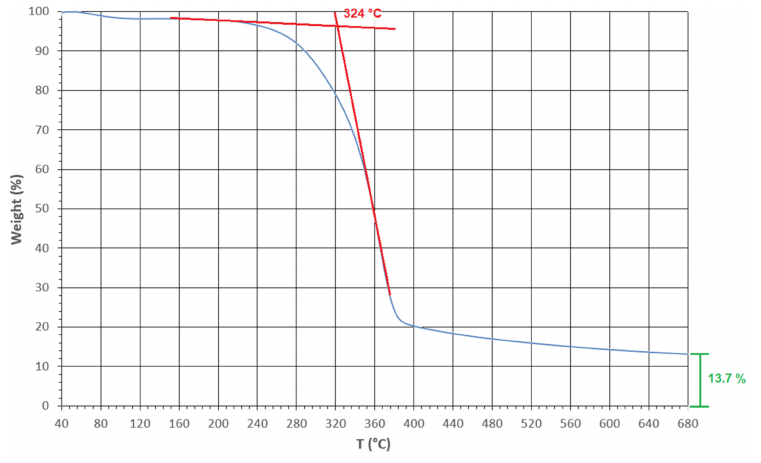
Figure 3. Thermogravimetric analysis (TGA) of